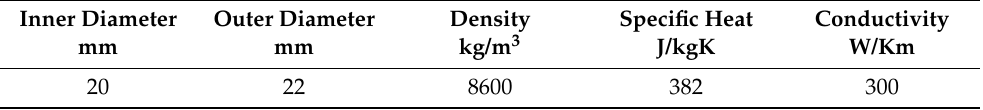
Table A3. Properties of copper tubes.